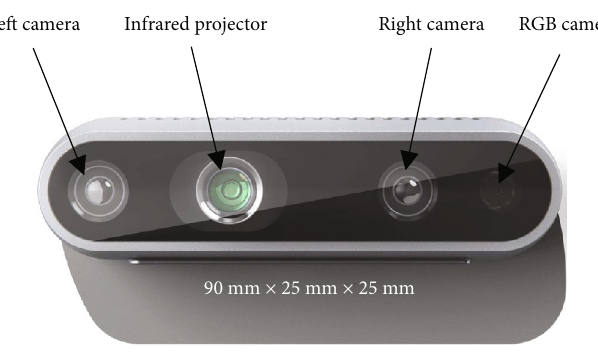
Figure 6: RealSense depth camera.